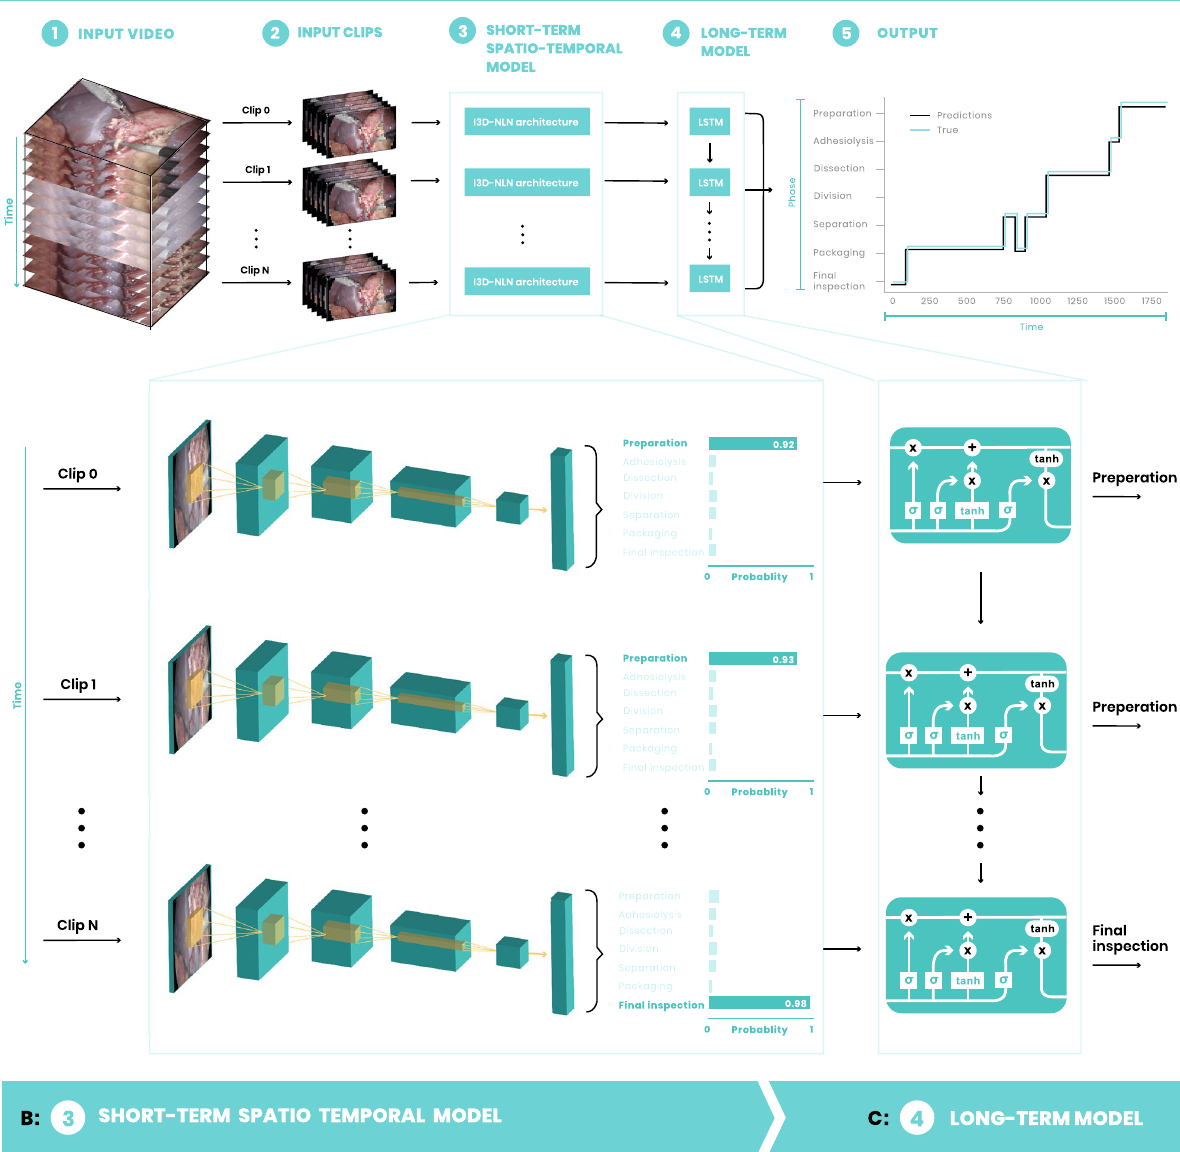
Figure 1. High-level flow. ( A ) The surgery input video (1) is divided into clips (2), one per second. Each clip is then fed to the short-term model which is based on an inflated 3D network with non-local blocks architecture (3). The predictions of (3) are sequentially fed to an LSTM network as part of the long-term model (4). The outputs of (4) are phase prediction for each second in the input video. Performance evaluation is done by comparing these predictions to the ground truth labels (5). The ground truth line is slightly indented in the y-axis to allow a better view of the results. ( B ) The short-term model process each clip independently to obtain a SoftMax probability vector, which represents a probability value for each phase as captured in the input clip. The probabilities are illustrated by the histograms on the right-hand side. ( C ) Probability values produced by the short-term model are applied to create a sequence of phases that are fed to a single layer LSTM network. The outputs of the long-term model are the final phase